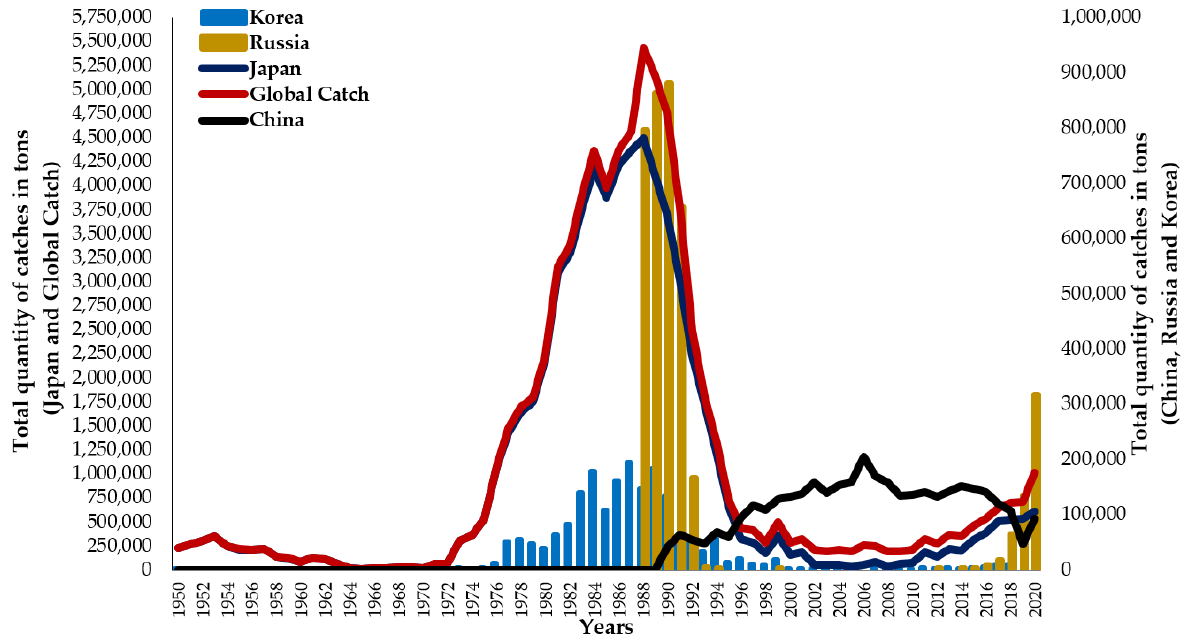
Figure 2. Evolution of global catches for Japanese sardine in the 4 main zones (Korea, Russia, Japan and China), from 1950 to 2020 [8,9].